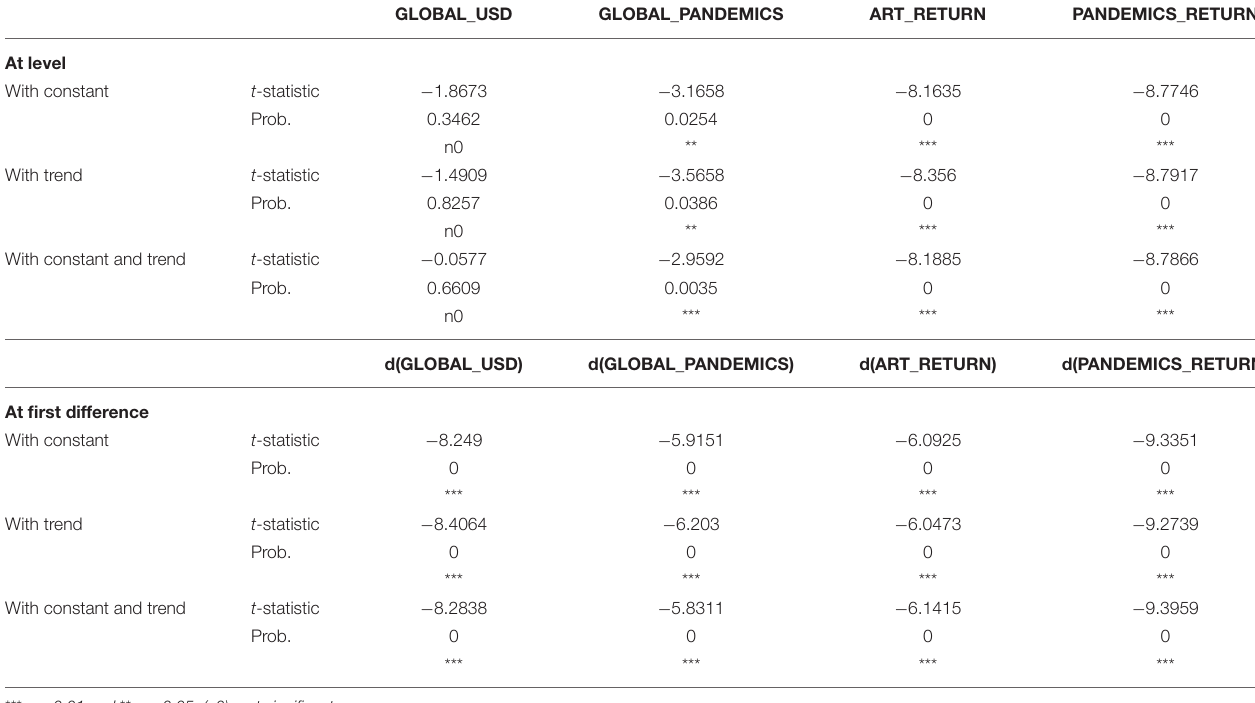
TABLE 3 | Results of the ADF unit root tests (1998Q1–2021Q2).